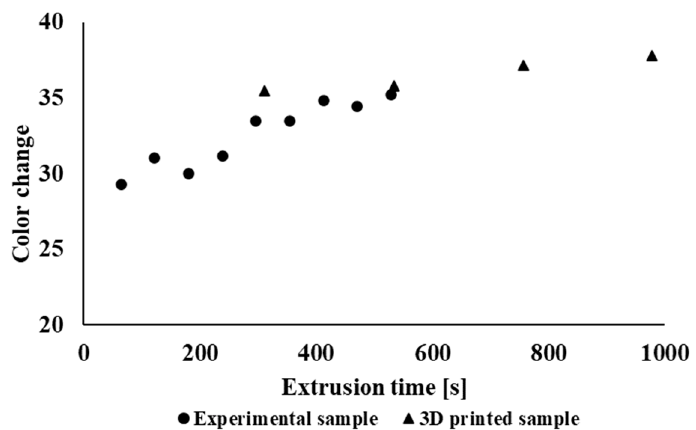
Figure 11. Dependence of the color difference of the material on the retention time of the material in the processing equipment.